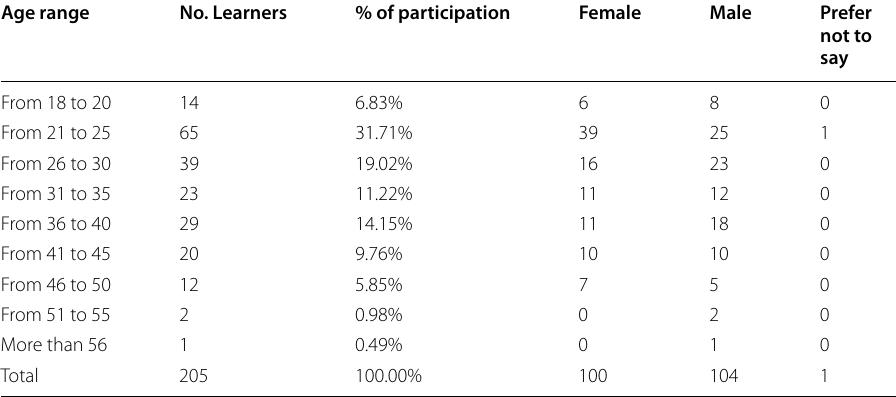
Table 10 Age range of respondents and gender distribution by age Age